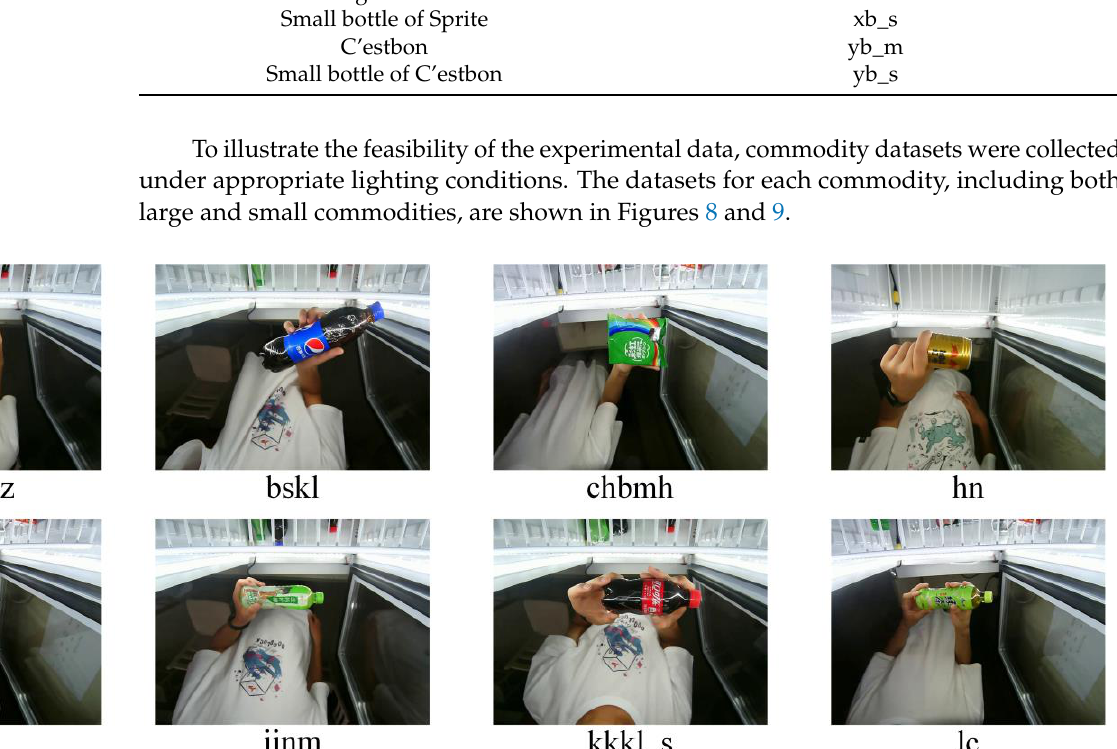
Figure 8. Sample datasets of each commodity.